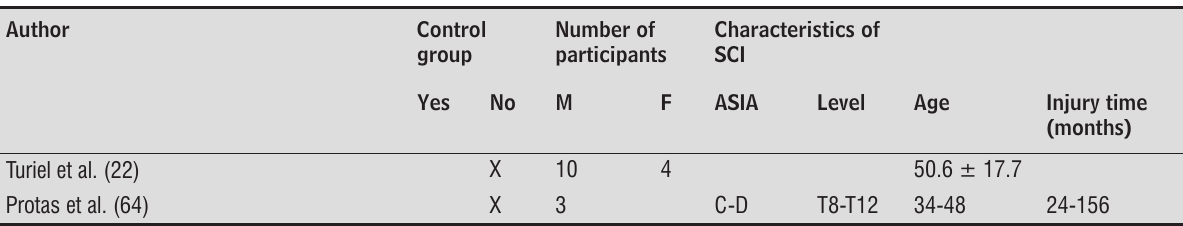
Table 1 - Sample and sampling classification used in researches on